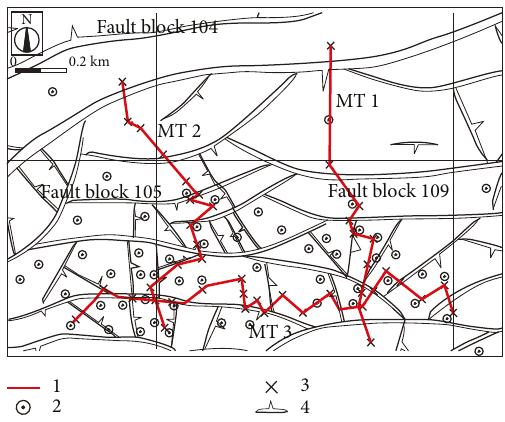
Figure 3: Fault distribution and gas fl ux measurement locations at the Dawanqi oil fi eld. (1) Measurement transect (MT), (2) oil wells, (3) measurement site, and (4) faults at the top of the Kangcun formation (from